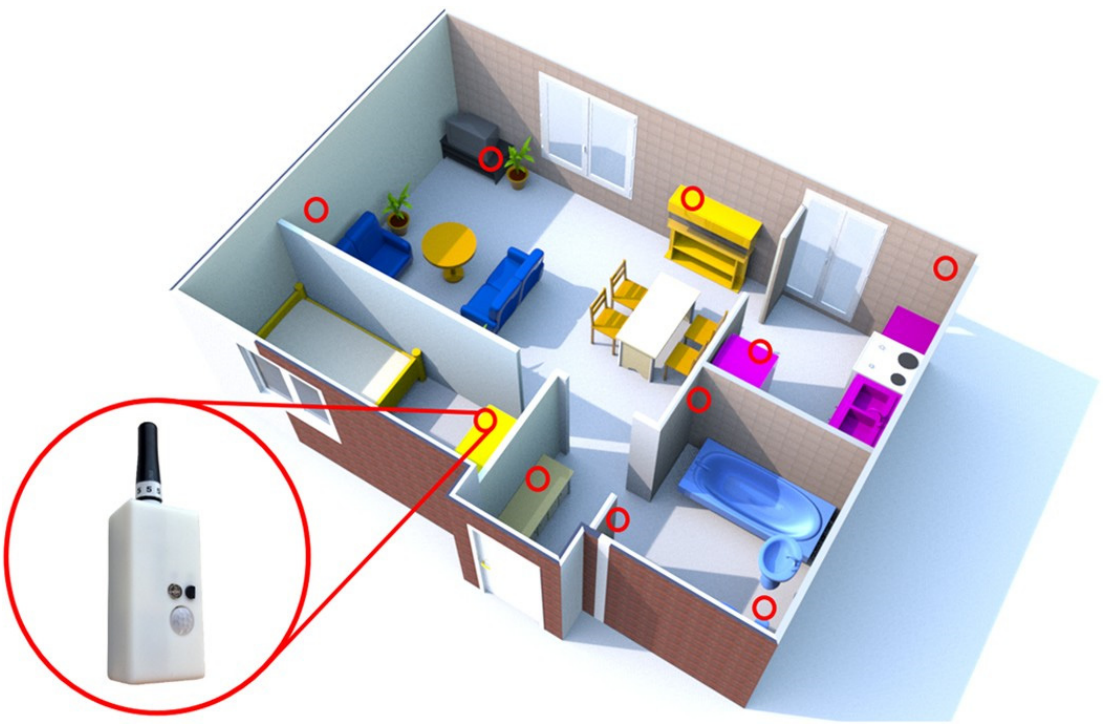
Figure 1. Floor plan of an apartment showing the placement of sensor boxes (red circles). The figure is adapted from Urwyler et al. [30] (CC BY 4.0).